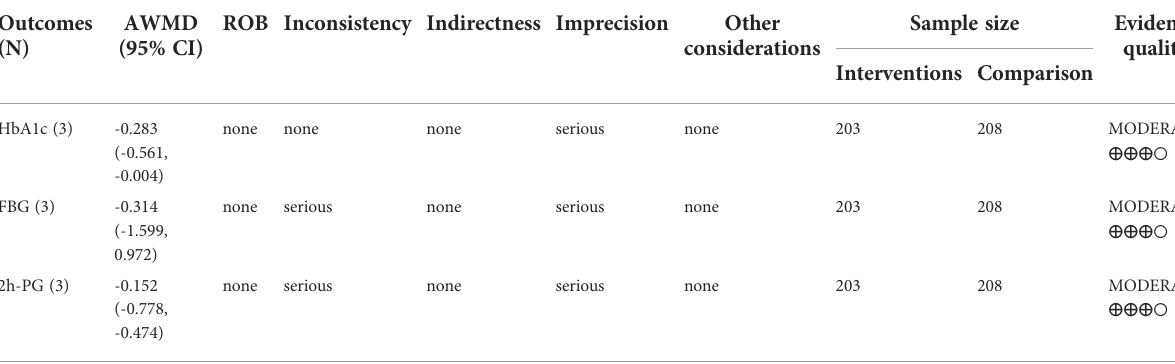
TABLE 2 The evidence quality for the outcomes (GRADE